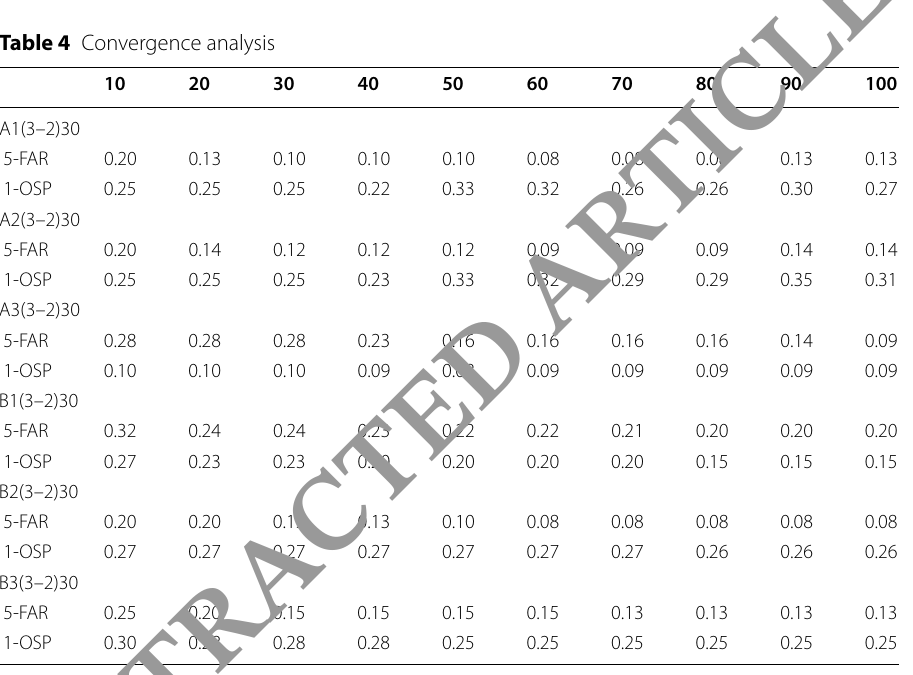
Table 4 Convergence